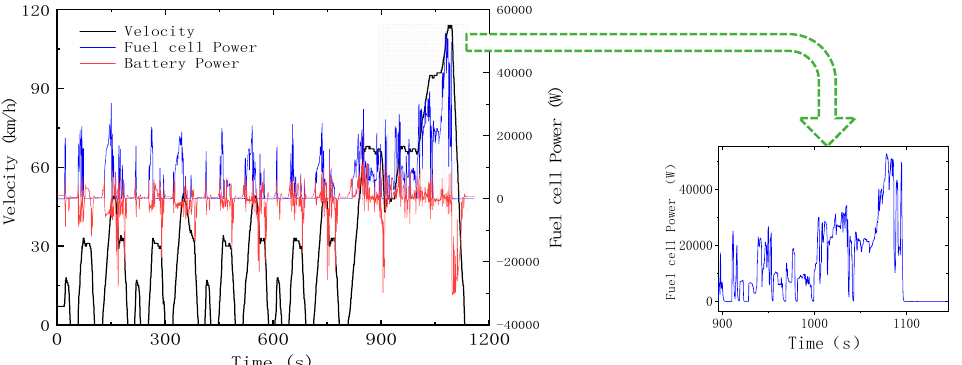
Figure 16. Changes in fuel cell and lithium battery power of FCHEV under New European Driving Cycle (NEDC).